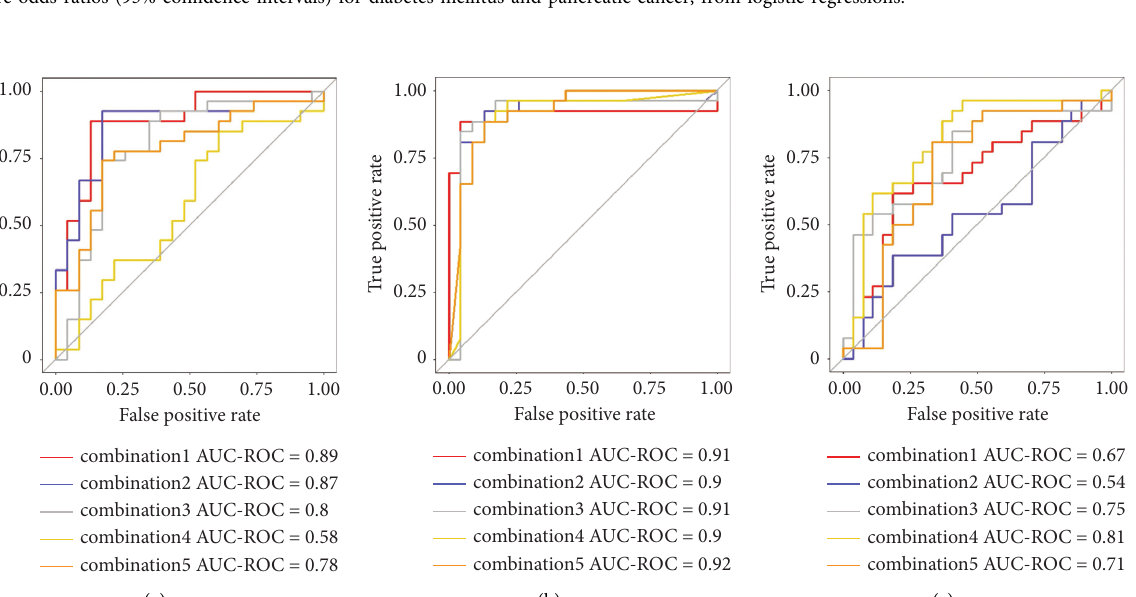
Values are odds ratios (95% confidence intervals) for diabetes mellitus and pancreatic cancer, from logistic regressions.